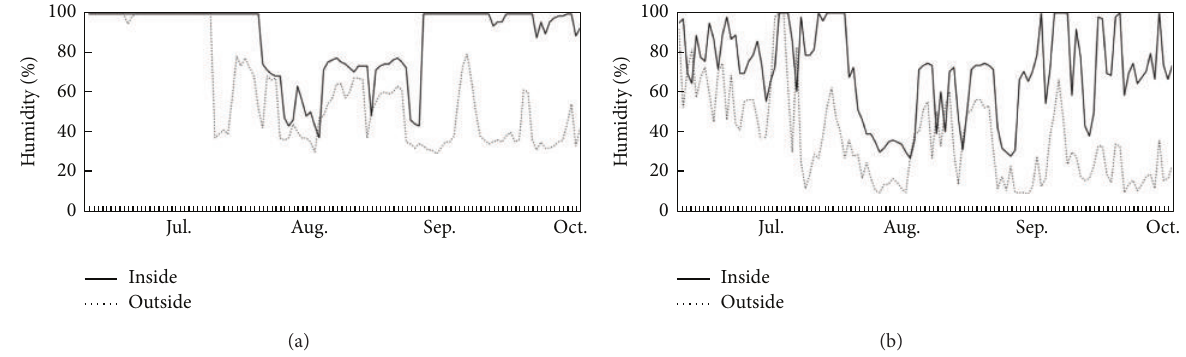
Figure 4: Daily maximum (a) and minimum (b) humidity near the ground from late June to October, 2011, inside and outside the deer exclosure in Okutama, western Tokyo, Japan.